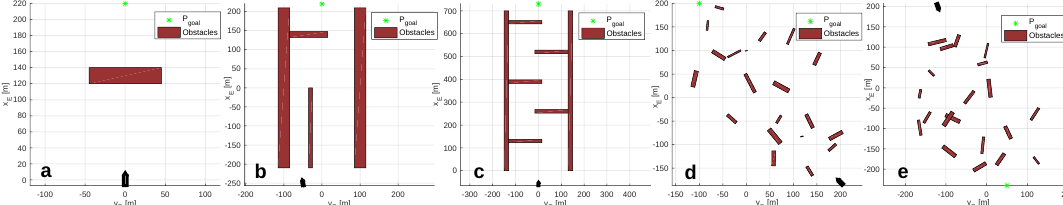
Figure 3. Obstacle scenarios used to evaluate the performances of SOA methods: ( a ) scenario 1, ( b ) scenario 2, ( c ) scenario 3, ( d ) scenario 4 and ( e ) scenario 5. Scenarios’ descriptions are available in